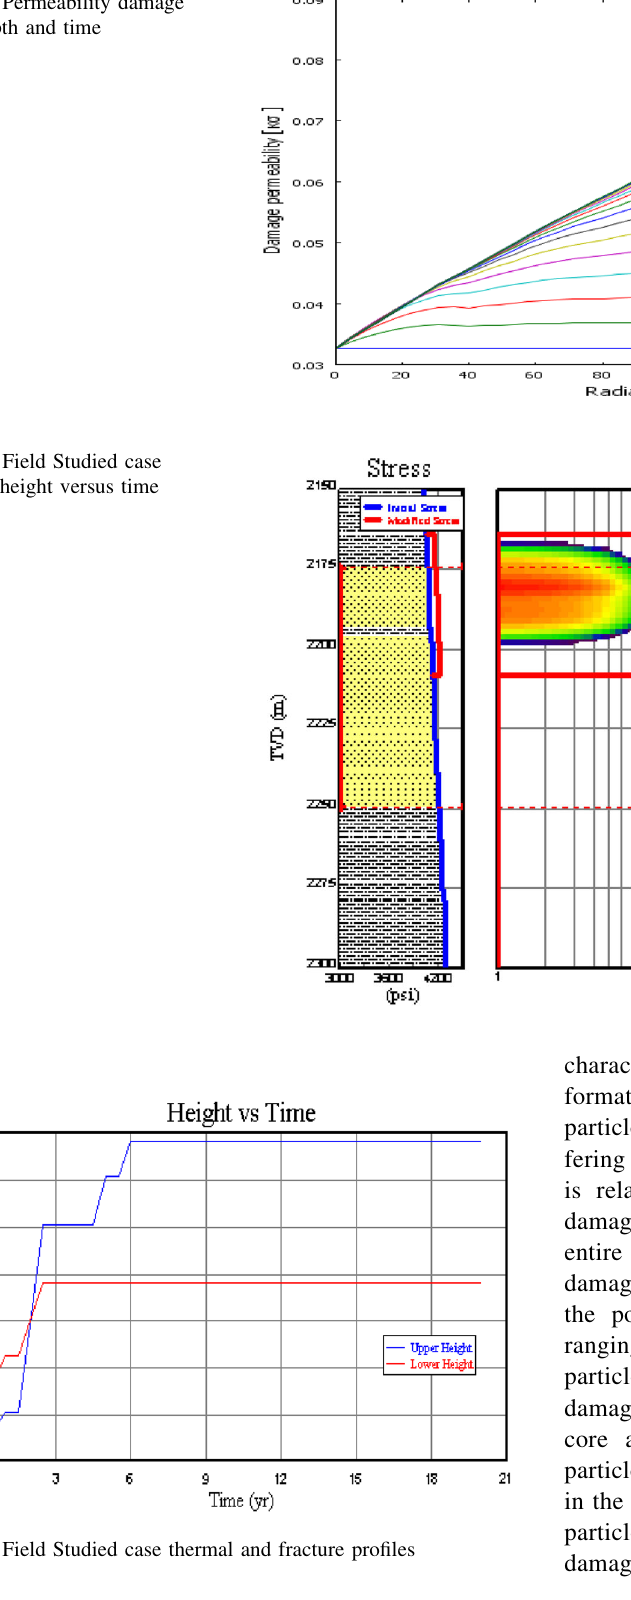
Fig. 11 Permeability damage with depth and time